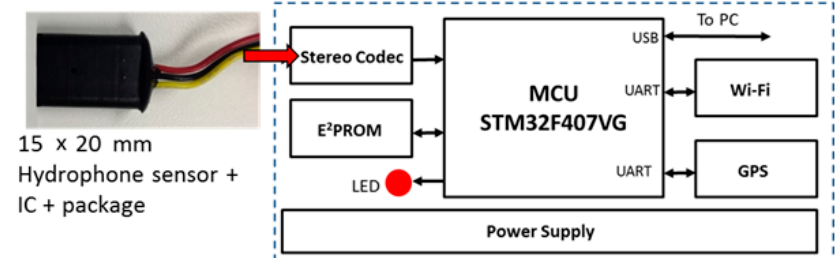
Figure 4. Wireless Sensor Node architecture.